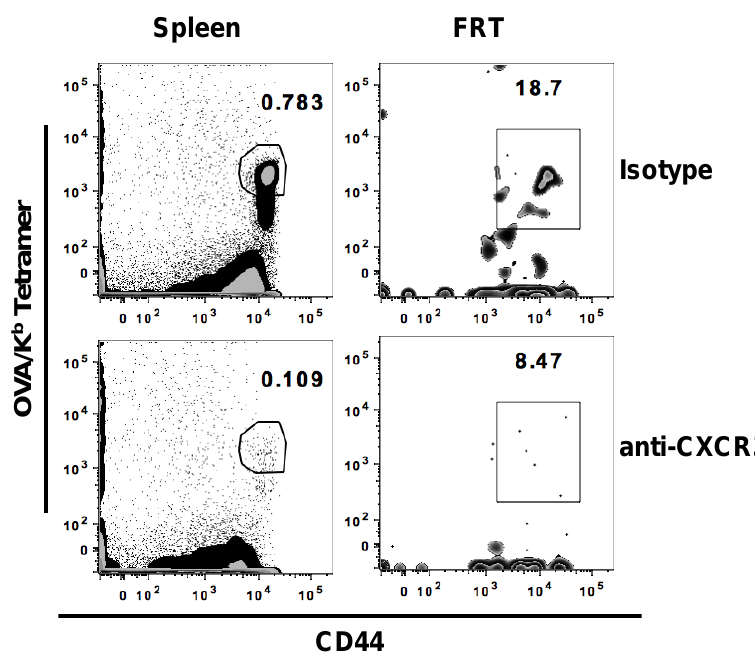
Figure 3. CXCR3 blocking limits the generation of antigen-specific T cells. Separate groups of mice were treated with either CXCR3 blocking antibody or isotype antibody a day before and a day after IN immunization with OVA and α GalCer. Mice were sacrificed on day 7 post-immunization and lymphocytes were isolated from the female reproductive tract (FRT) and spleen. Representative scatterplots of activated antigen specific CD8 + T cells in the different tissues is presented.